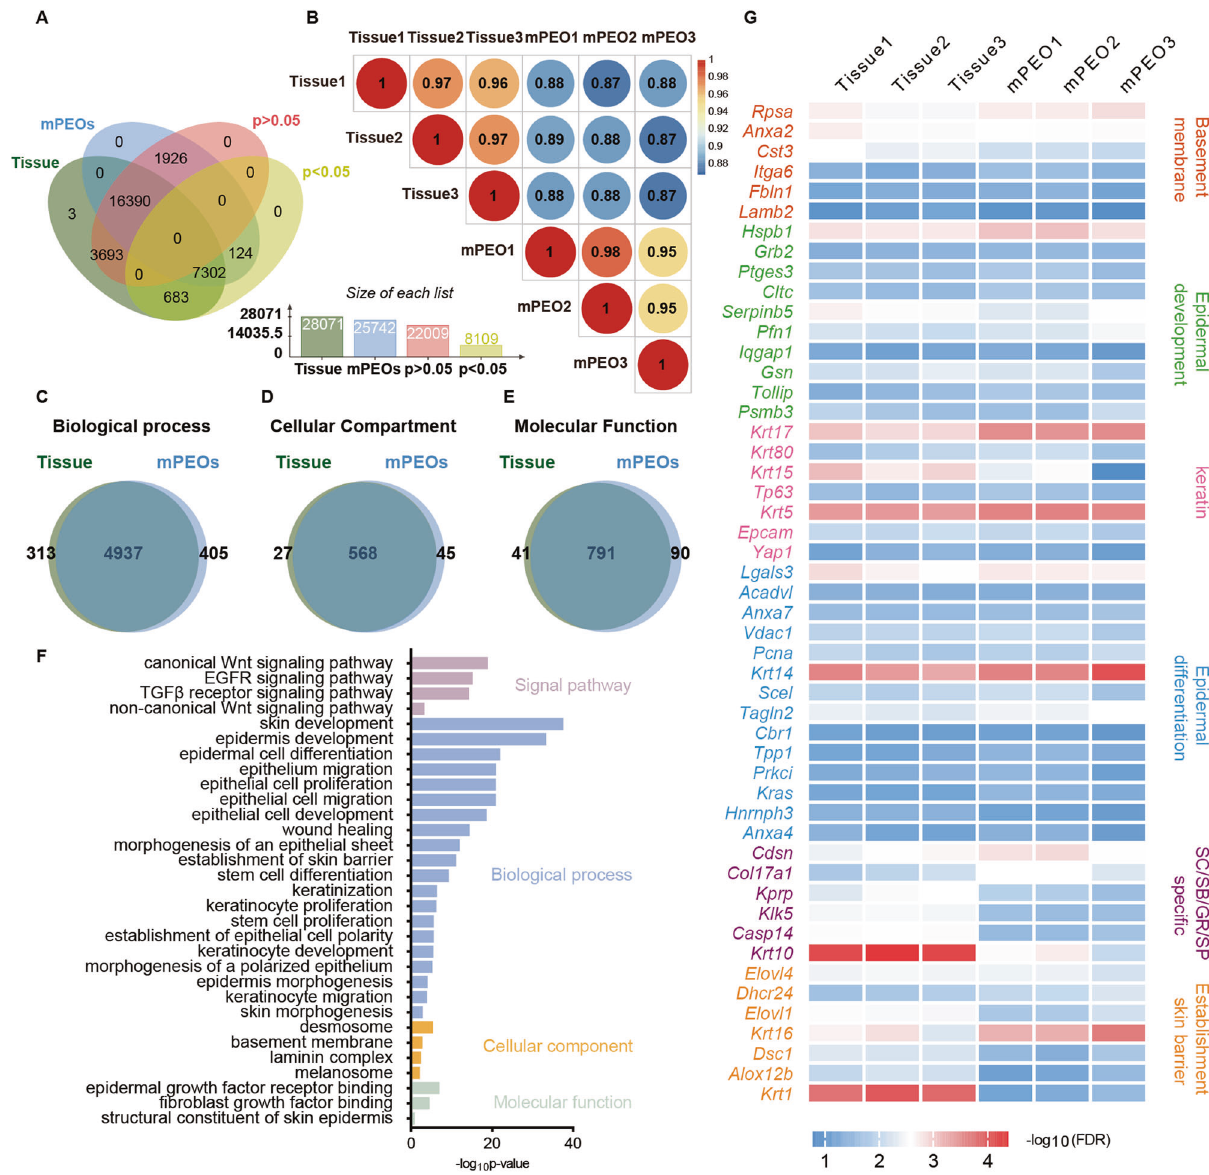
Fig. 2 Comparisons of transcriptomes between mPEOs and their derived skin tissue. A Venn diagram [41] showing the overlapping genes between mPEOs and their derived skin tissue. B The Pearson correlation values of gene expression between mPEOs and tissues. Functional analysis of genes identi fi ed in mPEOs. Gene ontology (GO) using C biological process and D cellular compartment and E molecular function distribution. F GO analysis of genes identi fi ed in mPEOs. The top signi fi cantly enriched GO terms describing skin-related genes are shown with the -log of their P values. G Heatmap analysis of differences in the expression levels of genes involved in the basement membrane, epidermal development, keratin, epidermal differentiation, SC/SB/GR/SP speci fi city and establishment of the skin barrier in mPEOs and their derived skin